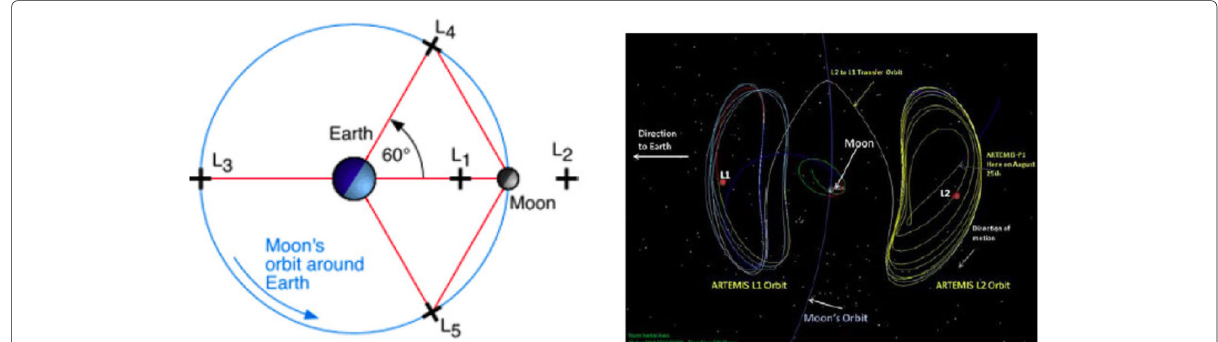
Fig. 4 Earth-Moon system Lagrange points and orbits. (Sources : lagrangianpoints.com /